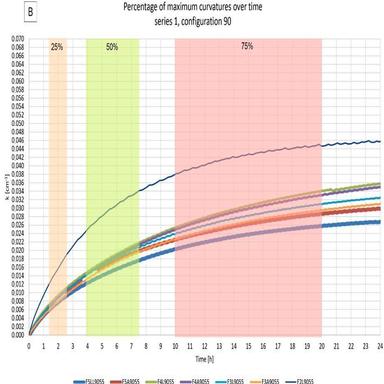
Different percentages of maximum curvature k over time of the first series, "configuration 90".